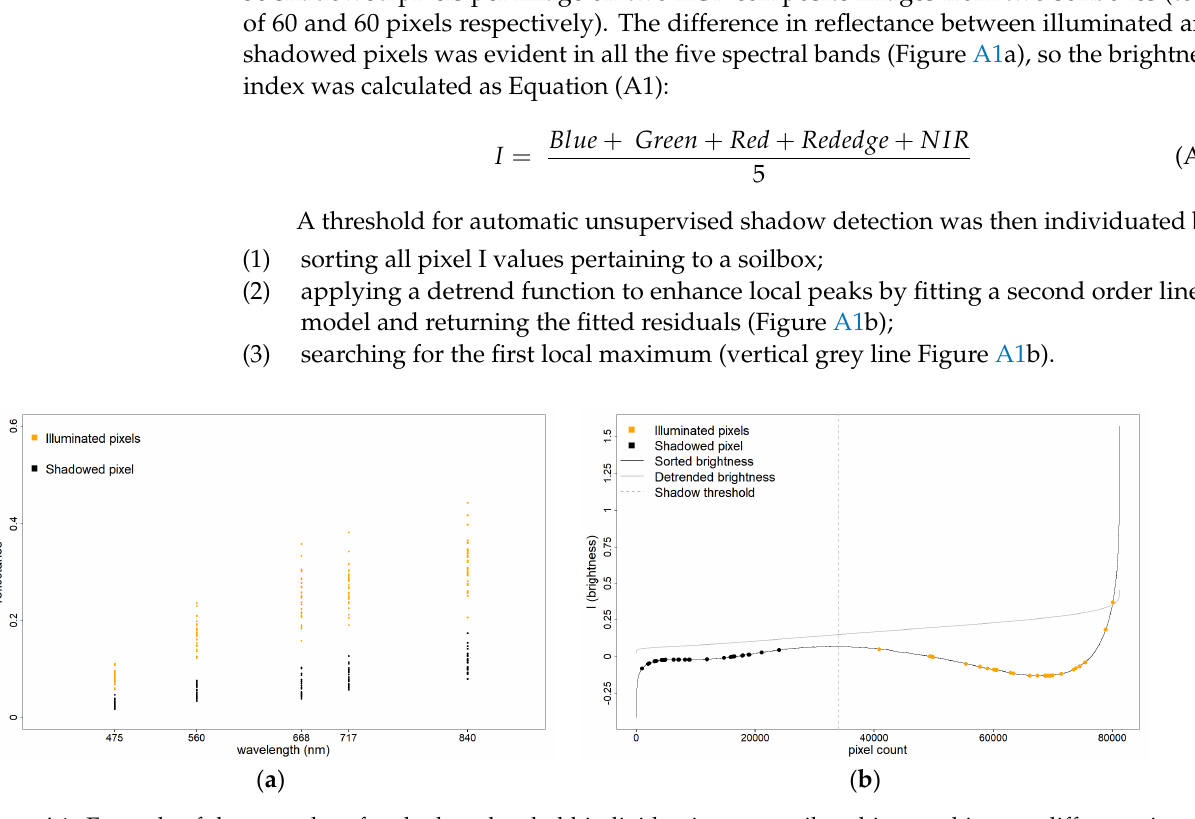
Figure A1. Example of the procedure for shadow threshold individuation on a soil multispectral image: difference in reflectance between illuminated and shadowed calibration pixel ( a ) and the brightness curves after sorting and detrending to make the shadow threshold stand out as a local maximum ( b ).